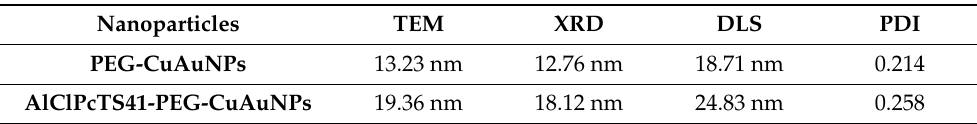
Figure 3. XRD spectra of PEG-CuAuNPs and AlPcTS41 together with their conjugate (AlPcTS41- PEG-CuAuNPs), demonstrating crystal peaks of the nanoparticles on both the alloy nanoparticles and the conjugates. Table 1. Average size distributions of PEG-CuAuNPs and AlClPcTS41-PEG-CuAuNPs, as investi- gated by different techniques.